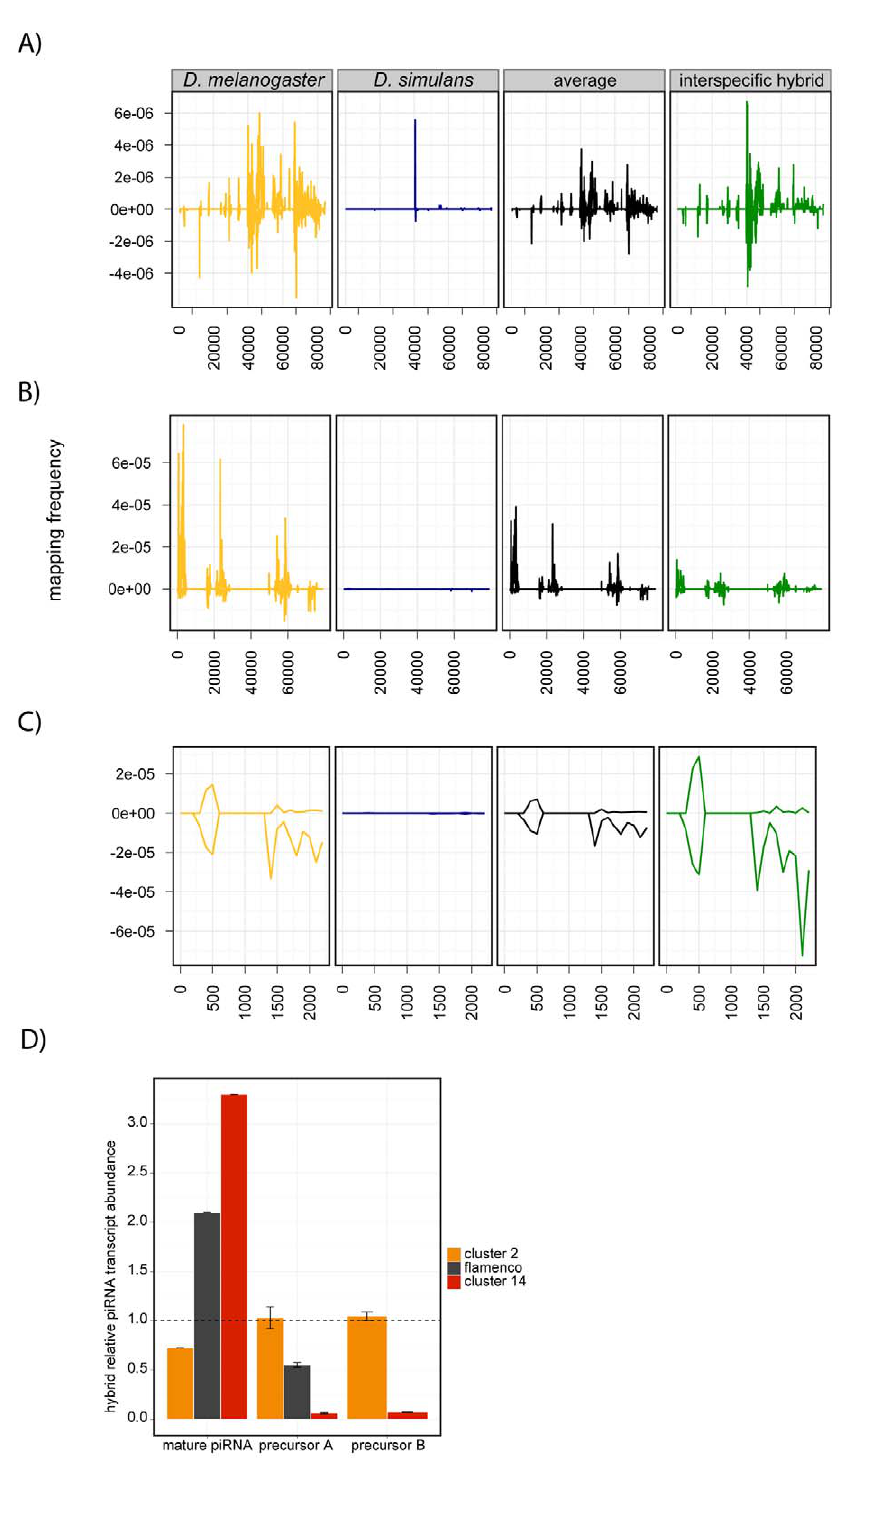
Figure 5. Aberrant activity of piRNA clusters in interspecific hybrids. (A–C) Frequency of uniquely mapping piRNAs derived from D. melanogaster piRNA clusters 9 (A), 5 (B), and 10 (C) for D. melanogaster (yellow), D. simulans (blue), and interspecific hybrids (green). Average indicates the additive expectation for interspecific hybrids (black). (D) Abundance of precursor transcripts (qRT-PCR) and mature piRNAs (small RNA-seq) from piRNA clusters 2, 14, and flamenco , relative to the interspecific average. Dotted line indicates no change in relative expression. Precursors A and B denote two independently measured locations in the precursor transcript.